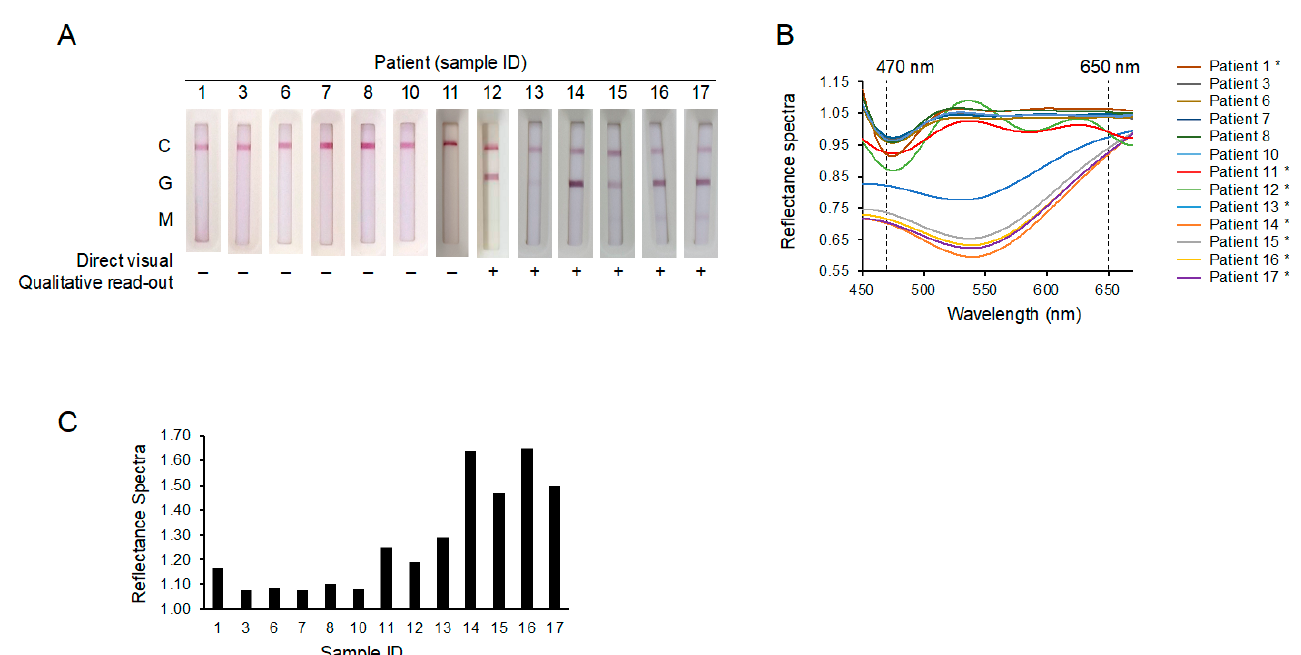
Figure 2. The excellent limit of detection prevented false-negative COVID-19 test results. ( A ) The results of the COVID-19 IgM/IgG test strips were used to test a panel of 13 suspected patients. Only patient ID#s 12, 13, 14, 15, 16, and 17 were clearly considered positive using a direct visual qualitative read-out. ( B ) The percentage of reflectance spectra derived from the patients’ test strips. Stars mark those patients who tested positive according to the spectrochip analysis. ( C ) The α value of patients’ reflectance spectra at 470 nm vs. 650 nm.